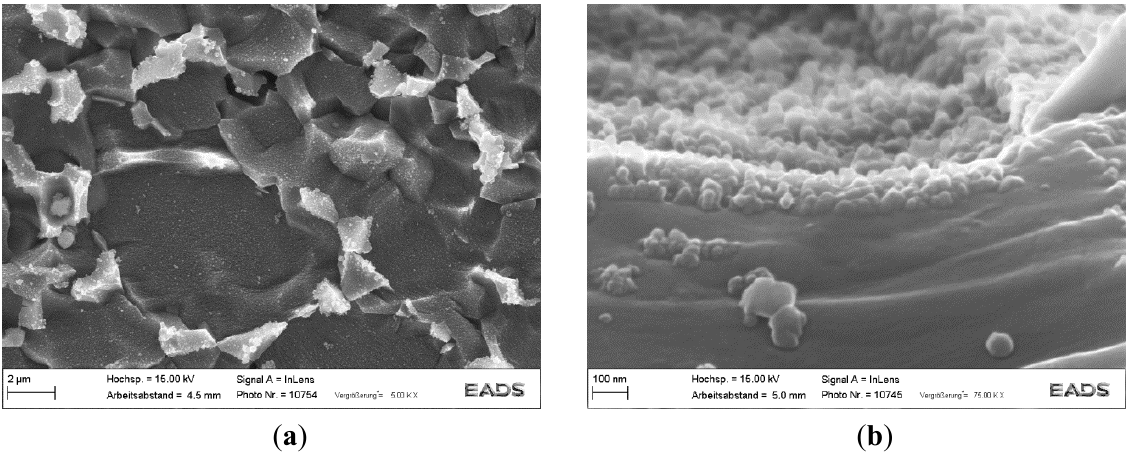
Figure 2. SEM micrographs after film deposition on Ti 6 Al 4 V ( a ) top view; ( b ) Cryo fracture of Ti 6 Al 4 V.